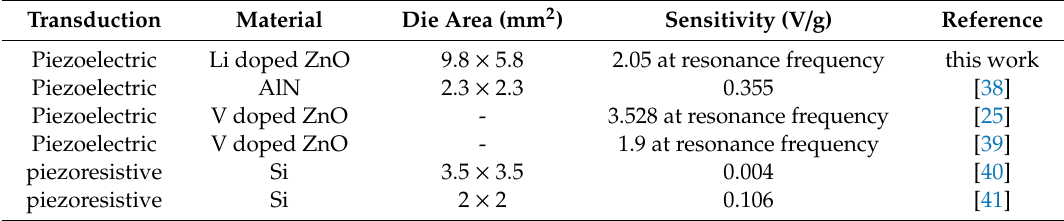
Table 2. Performance comparison of the proposed sensor with others.